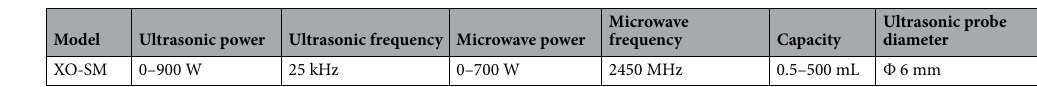
Table 1. Parameter of ultrasound- and microwave-assisted extracting apparatus.